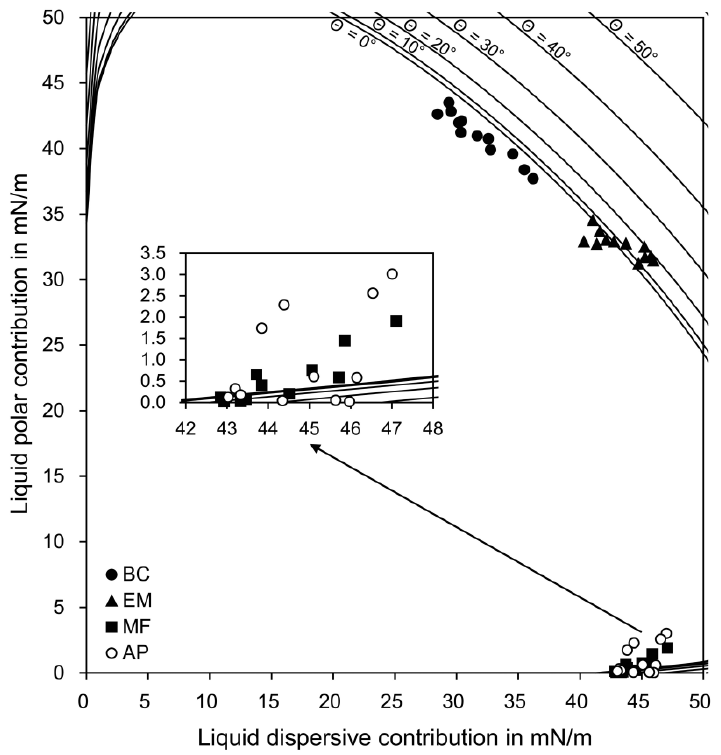
Figure 2. Wetting envelope of the dentin for 0–50°, showing each data point ( σ p ( σ d )) of the four sealers.